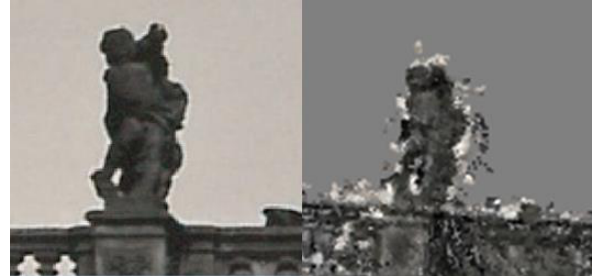
Figure 4. Comparison of a segment originated from a historical image (left) and a point cloud (right)